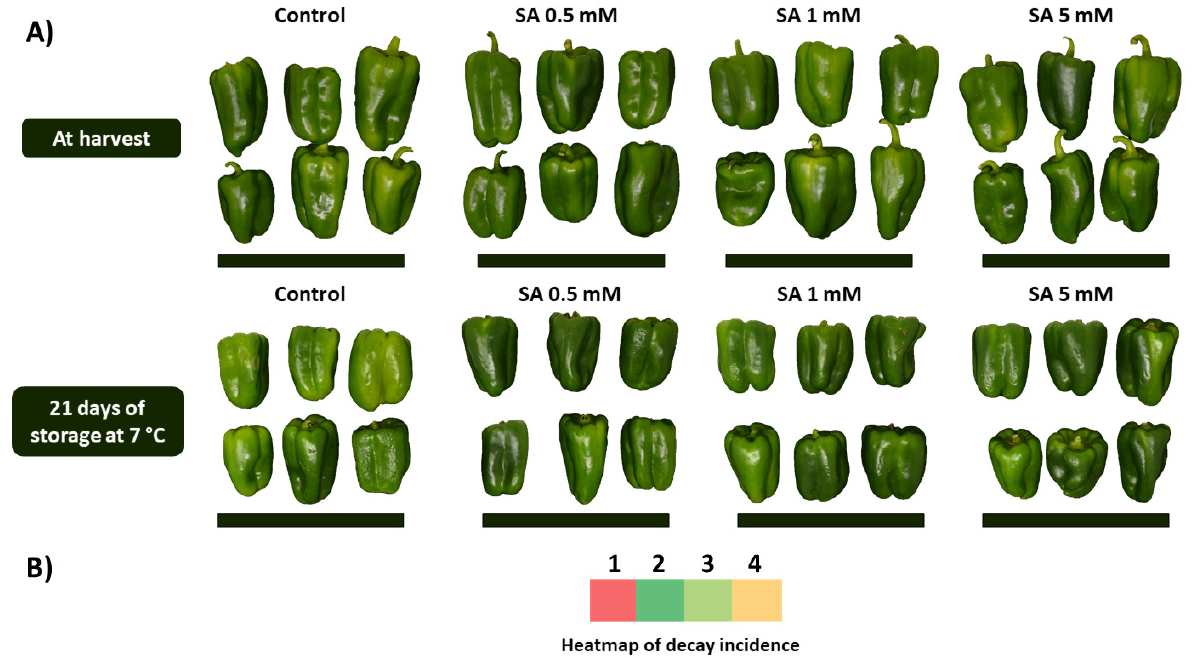
Figure 4. ( A ) Visual aspect of ‘Herminio’ cultivar harvested from one replicate of control plants and SA treated plants with three concentrations: 0.5, 1 and 5 mM, at harvest and after 21 days of storage at 7 °C. ( B ) Heatmap of decay incidence for ‘Herminio’ cultivar after 21 days of postharvest storage at 7 °C. Colors in the diagram represent the low or high percentage of incidence, ranging from green to red, respectively; and numbers below each color map represent the different treatments (1 = control; 2 = 0.5 mM SA; 3 = 1 mM SA; 4 = 5 mM SA).